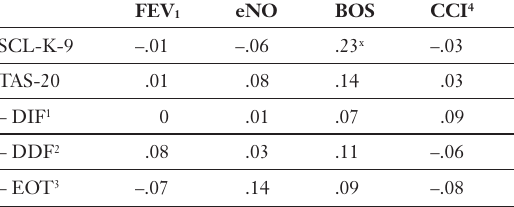
Correlations between distress/alexithymia and physical parameters (lung function FEV 1 , eNO, BOS, Charlson Index CCI) atT0, n =